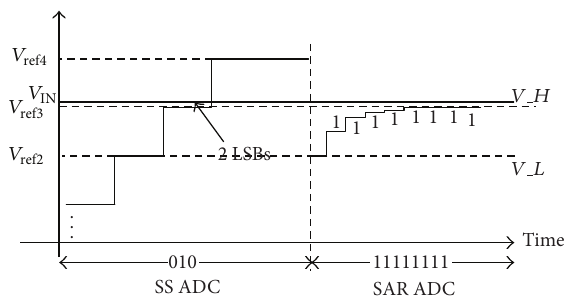
Figure 2: The example of how missing code is generated by the first stage ADC